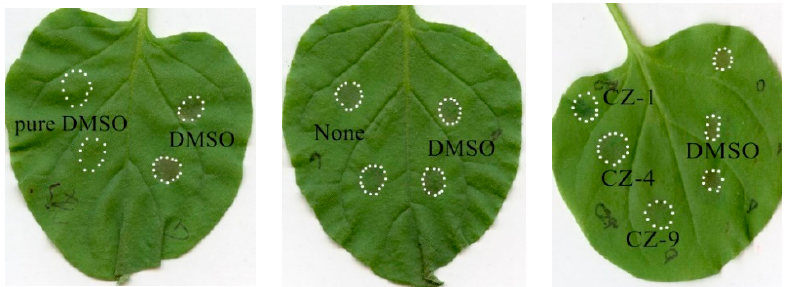
Figure 3. Effects of various compounds on the hypersensitive response (HR) induced by Xanthomonas oryzae pv . oryza e ( Xoo ) on Nicotiana benthamiana . Cell suspensions of wild-type Xoo PXO99 A (wild- type, WT) at an optical density of 600 nm (OD 600 ) of 0.5 were incubated with dimethylsulfoxide (DMSO) or each compound at a concentration of 200 μ M for 2 h before infiltration into tobacco leaves. Photographs were taken 24 h after infiltration. At least three independent experiments were performed with similar results.